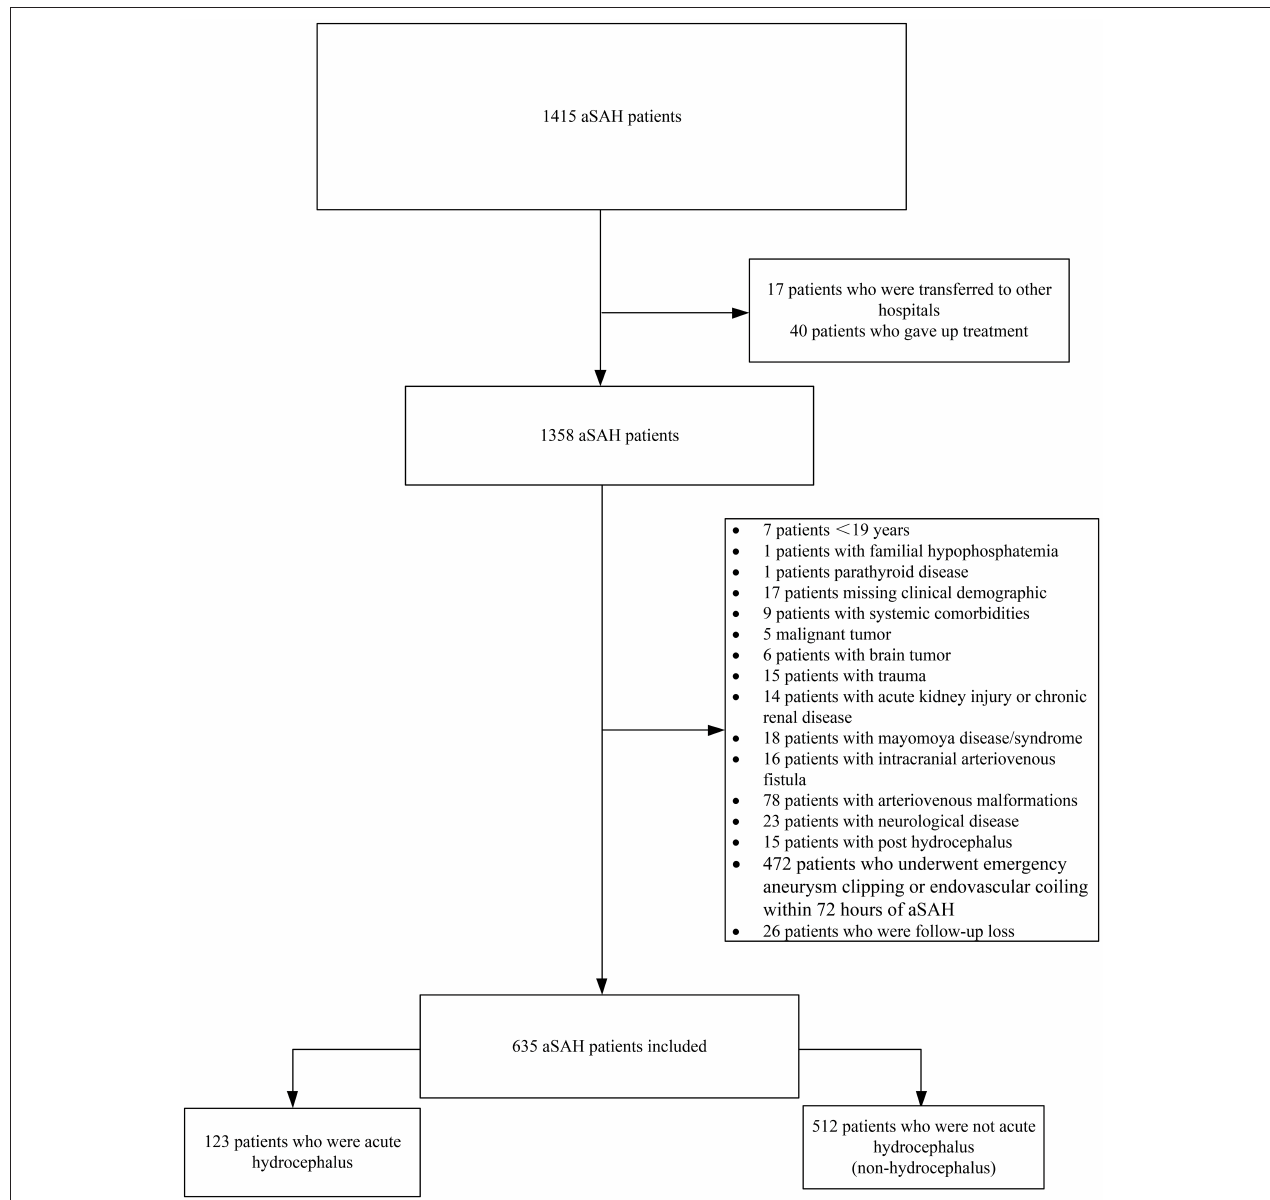
FIGURE 1 | Study population of flow chart. aSAH, aneurysmal subarachnoid